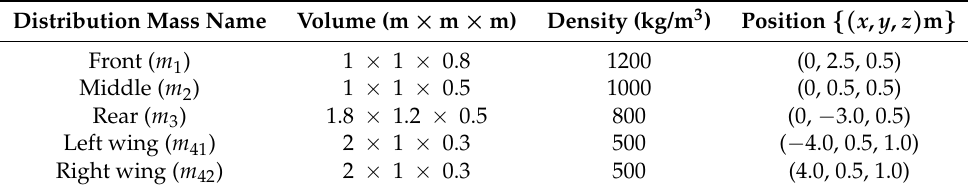
Figure 2. Schematic diagram of the distribution mass for the carrier. Table 1. Parameters of the distribution mass for the